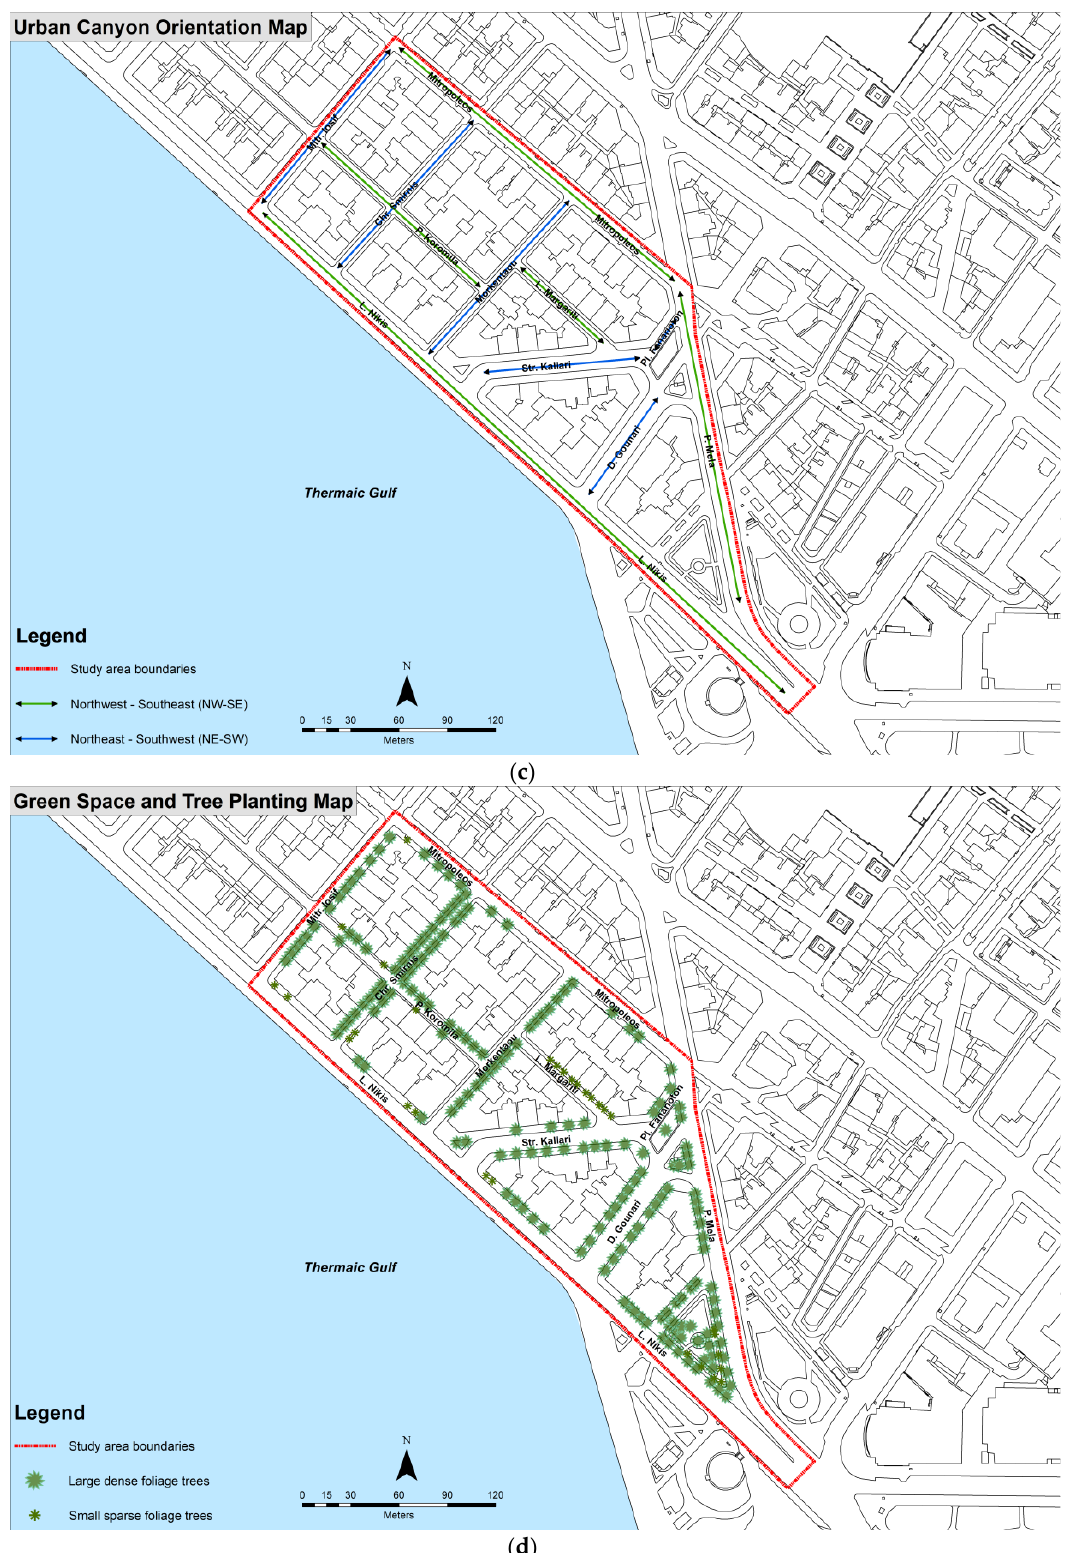
Figure 3. ( a ) Land-use map; ( b ) Structured—unstructured space (within each building block) map; ( c ) Urban canyon orientation map; ( d ) Green space and tree planting map, ArcGIS